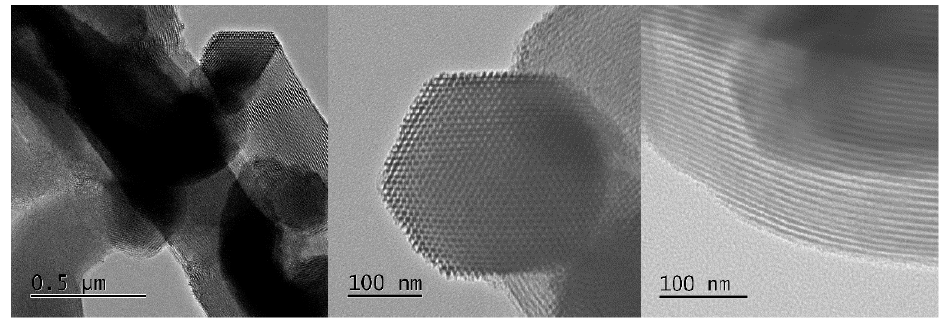
Figure 7. Transmission electron microscopy (TEM) images of the S15 precursor silica specimen.